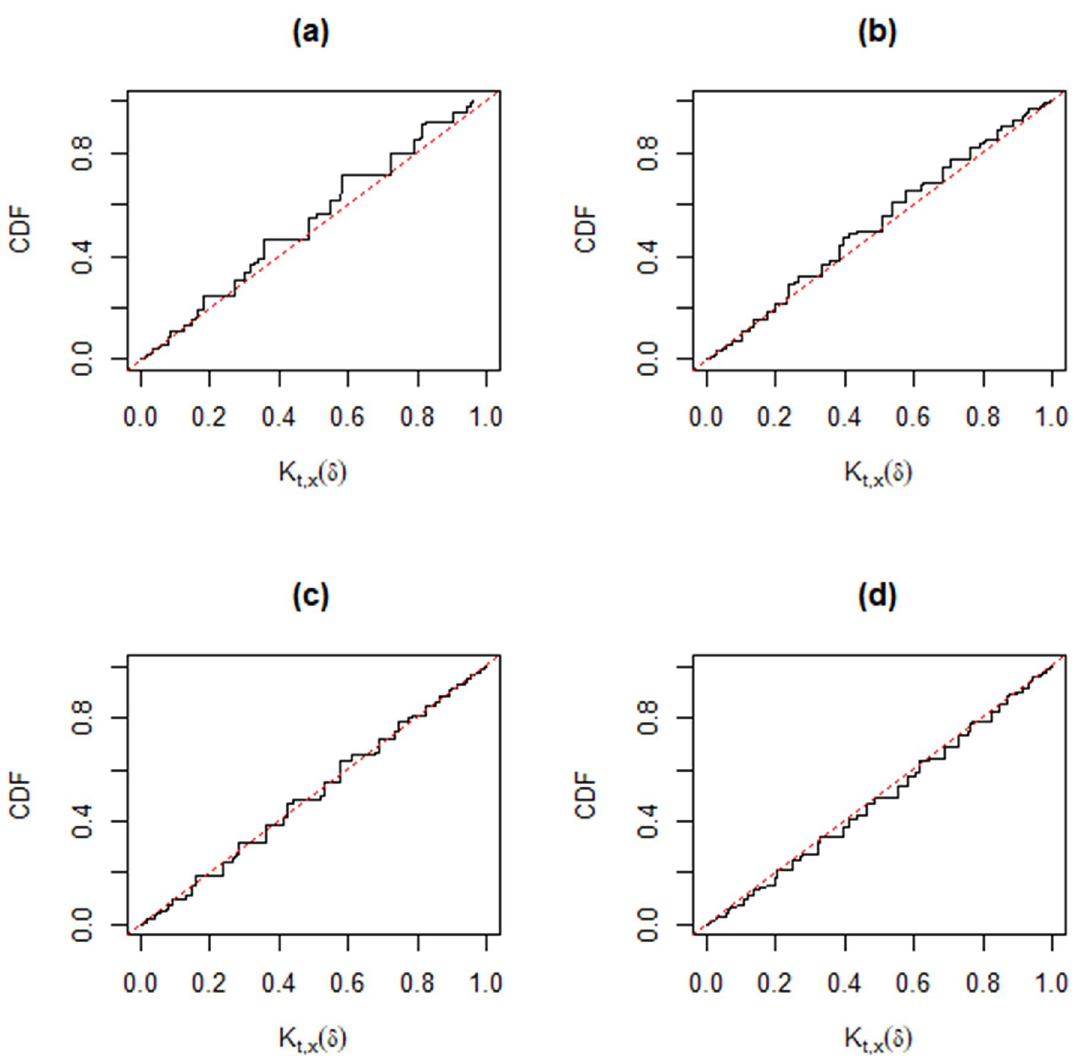
Fig 4. Distribution functions of K ( δ ) (black) compared with that of Unif(0, 1) (gray) based on Monte Carlo samples from the t , x trinomial distribution versus p 12 for fixed n = 20 and p 11 = 0.1. Panel (a): p 12 = 0.1. Panel (b): p 12 = 0.2. Panel (c): p 12 = 0.3. Panel (d): p 12 =